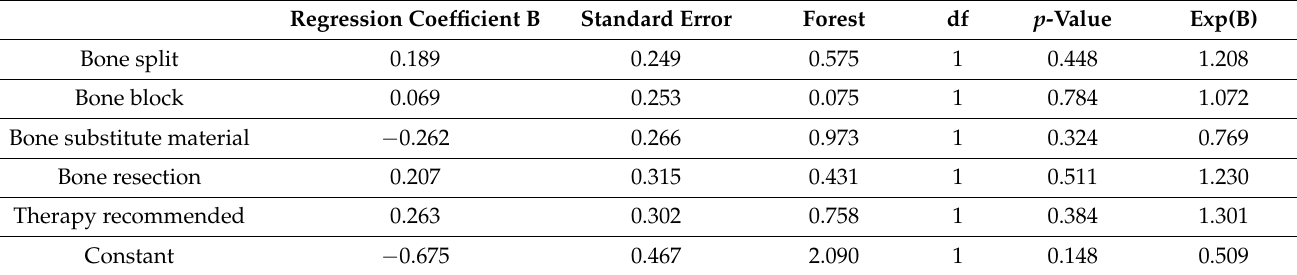
Table 2. Association between the dependent variable “specialist designation” (maxillofacial vs. oral surgeon) and the independent variables “bone split”, “bone block”, “bone substitute material”, “bone resection”, and “therapy recommended” for Case Vignette 1.